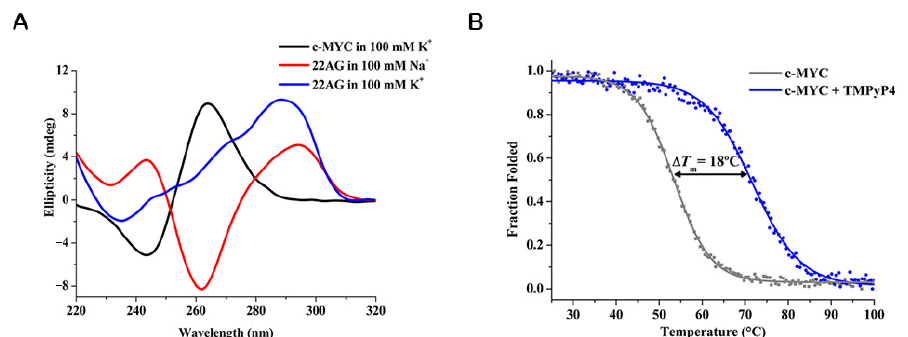
Figure 11. ( A ) CD spectra of G4 structures: c-MYC (10 µ M) in 100 mM KCl (parallel); 22AG (10 µ M) in 100 mM NaCl (antiparallel) and 22AG (10 µ M) in 100 mM KCl (hybrid). The final volume of each sample in the 1 cm path-length quartz cell was 300 µ L. The buffer used for the experiments was 10 mM phosphate buffer pH 7.1. ( B ) CD melting curves for c-MYC G4 (10 µ M) in 100 mM LiCl in the absence and presence of 2 molar equivalents of TMPyP4. The ellipticity was monitored at a wavelength of 263 nm. The buffer used for the experiments was 10 mM phosphate buffer pH